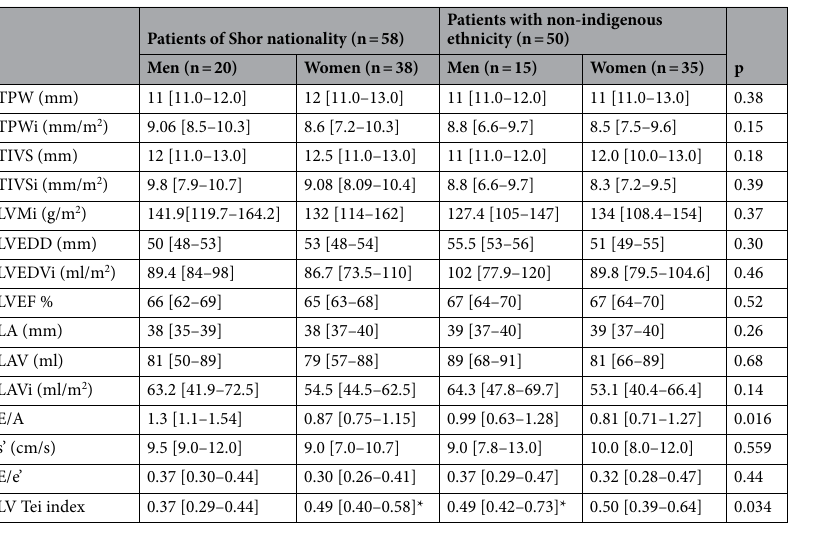
Table 2. Left ventricular and atrial parameters in hypertensive patients of various ethnic groups. TPW— posterior wall thickness, TIVS—interventricular septum thickness LVM—LV myocardial mass, LVEDD—left ventricular end-diastolic diameter, LVEDV—left ventricular end-diastolic volume, LVEF—left ventricular ejection fraction LA—left atrium, LAV—left atrium; All structural indicators were indexed to the body surface area; E—early diastolic mitral flow (pulse Doppler); A—late diastolic mitral flow (pulse Doppler); e’ early diastolic relaxation velocity, s’—systolic velocity of lateral mitral annulus (tissue Doppler), LV—left ventricular; * p < 0.05 compared with Shor